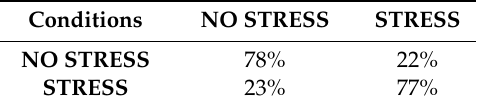
Table 5. Confusion matrix of the classification